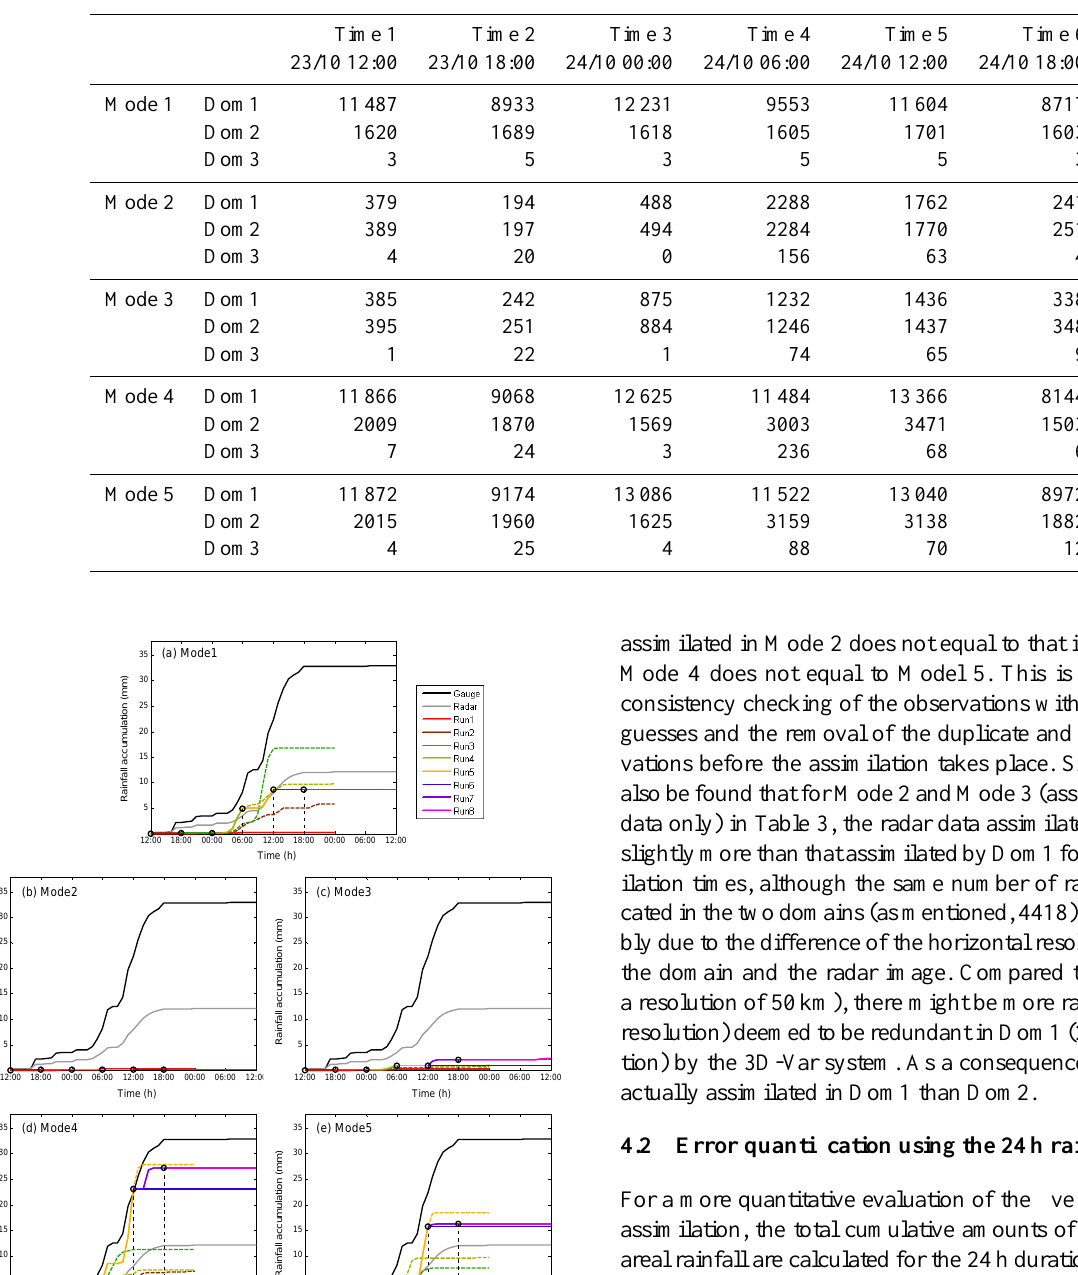
Table 3. Number of observations actually assimilated in each of the triple nested domains.